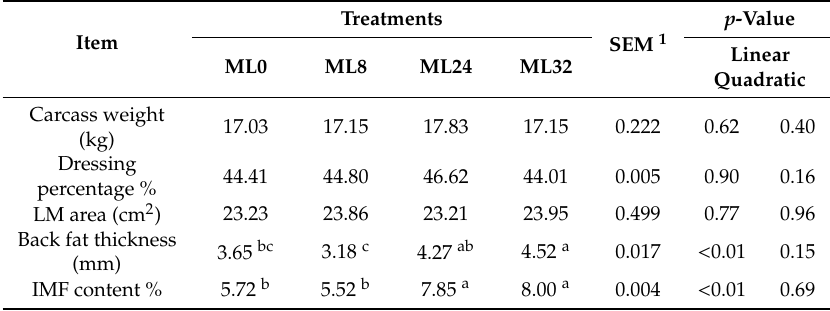
Table 6. E ff ects of inclusive ML treatments on carcass characteristics of sheep.